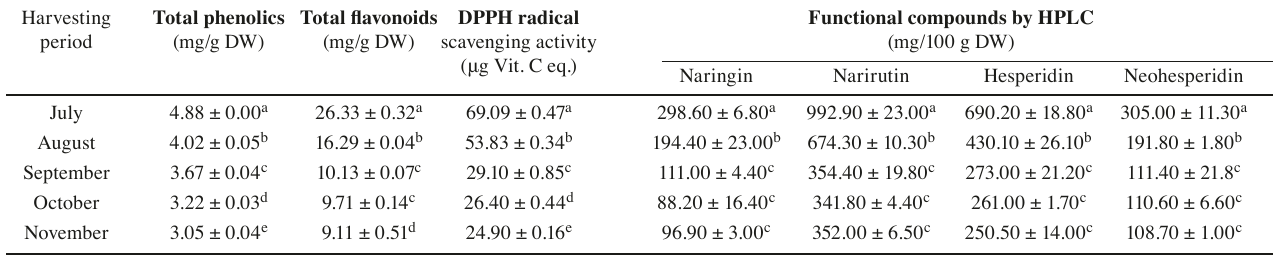
Tab. 1: Functional components of yuzu extracts by harvesting period.